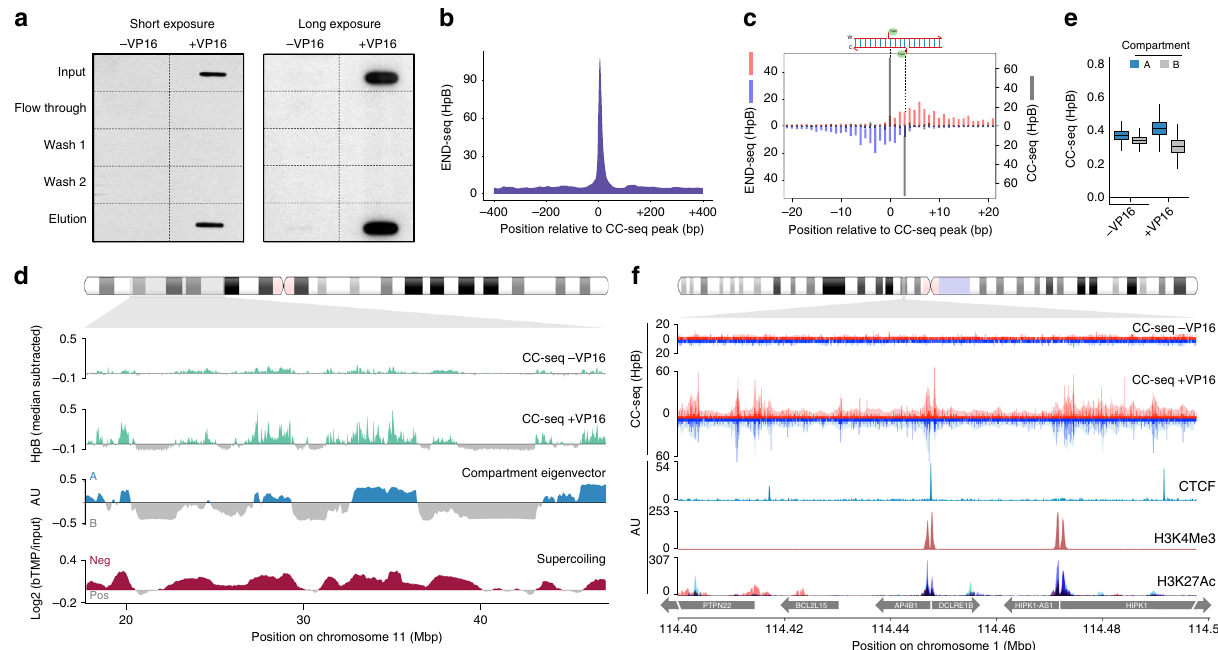
Fig. 3 CC-seq maps TOP2-linked DNA breaks in human cells with nucleotide accuracy. a Anti-TOP2 β western slot blot of input, fl ow through, wash, and elution fractions. RPE-1 cells were treated or not with 100 µ M VP16, prior to processing according to Fig. 1a. b Medium-scale aggregate of END-seq mapped DSBs 18 surrounding nucleotide resolution CC-seq mapped TOP2 CCs. c Fine-scale strand-speci fi c aggregate of END-seq mapped DSB ends (red and blue bars) and nucleotide resolution CC-seq mapped TOP2 CCs (grey bars) surrounding strong TOP2 CC sites. d Broad-scale CC-seq maps of TOP2 CCs produced in human RPE-1 cells ± VP16. Raw data were scaled, binned, smoothed and median subtracted prior to plotting. Chromatin compartments revealed by Hi-C eigenvector analysis 47 , and supercoiling revealed by bTMP ChIP-seq 44 are shown for comparison. e Quanti fi cation of TOP2 CCs in chromatin compartments A and B. Data are expressed as box-and-whisker plots of density as for Fig. 2d. f Fine-scale CC-seq maps of TOP2 CCs produced in human RPE-1 cells ± VP16. Red and blue traces indicate TOP2-linked 5 ′ DNA termini on the Watson and Crick strands, respectively. Data in pale shaded areas has been smoothed according to local density. RPE-1 CTCF and H3K4Me3 ChIP-seq data plus H3K27Ac ChIP-seq data overlaid from seven cell lines 71 is shown for comparison. HpM, HpB Hits per million (or billion) mapped reads per base pair. Source data are provided as a Source Data fi